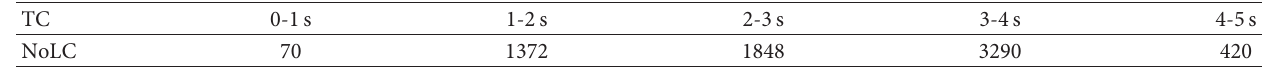
Table 3: Number of lane changes and time cost.